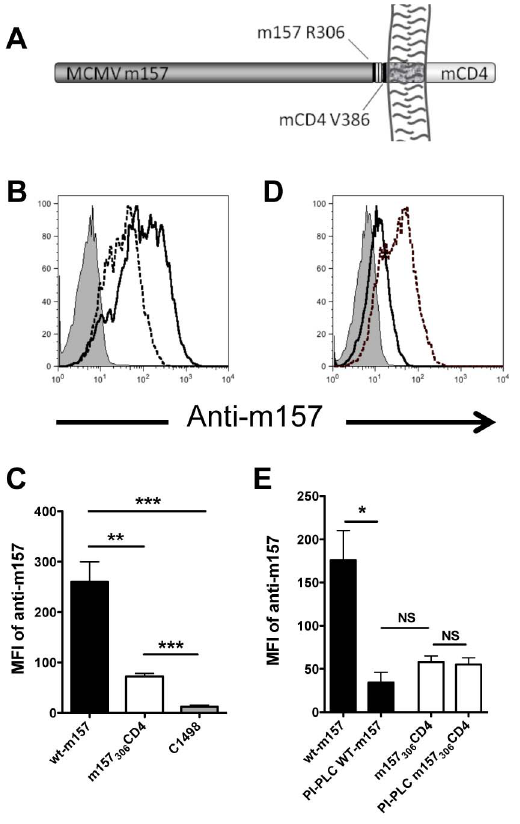
Figure 1. Expression of m157 as a transmembrane protein results in lower surface expression than GPI-anchored m157. C1498 cells were transfected with GPI-anchored m157 (wt-m157) or transmembrane-anchored m157 (m157 306 CD4). ( A ) Schematic of the m157 306 CD4 construct. ( B ) Surface expression of m157 as determined by flow cytometry using the anti-m157 mAb 6D5 in C1498 cells, representative of 7 experiments. Shaded grey histogram shows untransduced C1498 cells, solid line illustrates wt-m157, and dotted line represents m157 306 CD4. ( C ) Mean fluorescent intensity of surface wt-m157 and m157 306 CD4; data are accumulated from 7 experiments. ( D ) C1498 transfectants were treated with PI-PLC and then surface expression of m157 was determined by flow cytometry as in B . Data are representative of 3 experiments. ( E ) Mean fluorescent intensity of surface wt-m157 or m157 306 CD4 before and after PI-PLC treatment; data are accumulated from 3 experiments. NS, not significant ( P . 0.05); * P , 0.05; ** P , 0.005; *** P , 0.001 (two-tailed unpaired Student’s t- test). Error bars C , E , depict standard error of the mean, SEM.